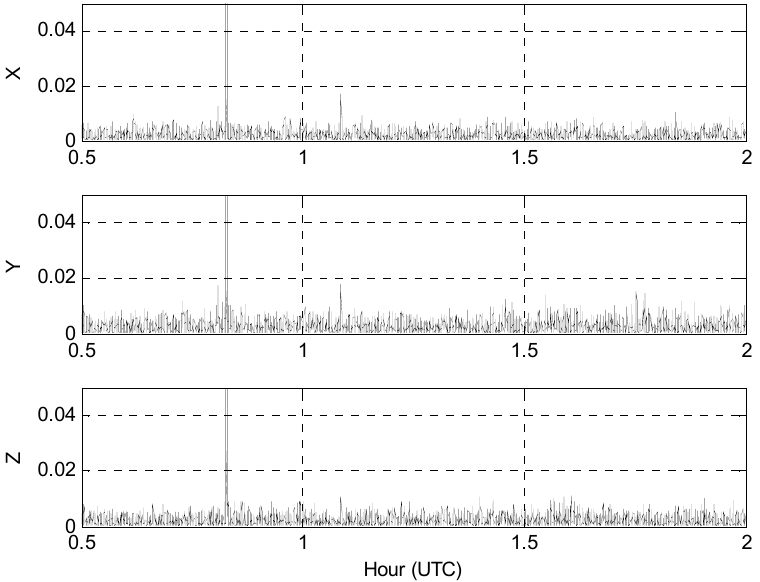
Figure 9. Receiver A minus receiver B WCF acceleration root-mean-squared differences in m/s 2 from Figure 7.